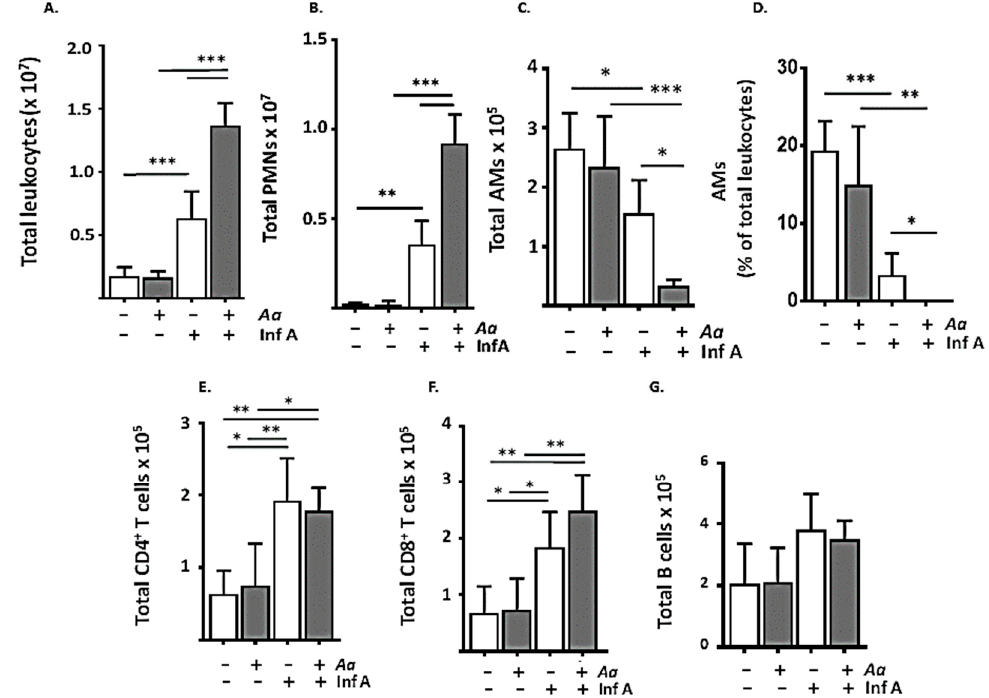
Figure 3. Repetitive administration of A. alternata amplifies total neutrophil recruitment and accelerates loss of alveolar macrophages in response to infection with Inf A. ( A ) Total leukocytes and ( B ) total PMNs recruited to lung tissue in mice treated with A. alternata (5 µ g per inoculum) prior to infection with a sublethal inoculum of Inf A compared to that observed in response to inoculation with Inf A alone. ( C ) Infection with Inf A results in a loss of AMs; repetitive exposure to A. alternata (5 µ g per inoculum) prior to Inf A infection amplifies this response. ( D ) AMs as percent of total leukocytes in A. alternata -treated Inf A-infected mice are reduced to undetectable levels; n = 5 per group, * p < 0.05, ** p < 0.01; *** p < 0.005, 1-way ANOVA. By contrast, repetitive administration of A. alternata (5 µ g per inoculum) had no impact on ( E ) total CD4 + T cells, ( F ) total CD8 + T cells, or ( G ) total B cells recruited to the lungs in response to infection with Inf A; n = 5 mice per group, day 6 as per Figure 1A; * p < 0.05, ** p < 0.01, 1-way ANOVA.